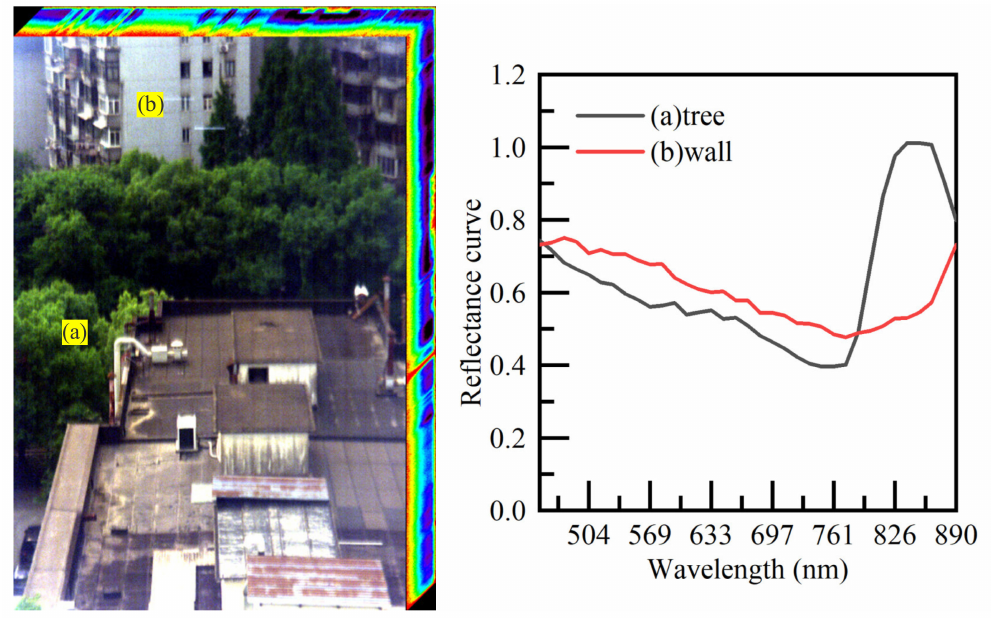
Figure 8. Spectral restoration image and spectral reconstruction